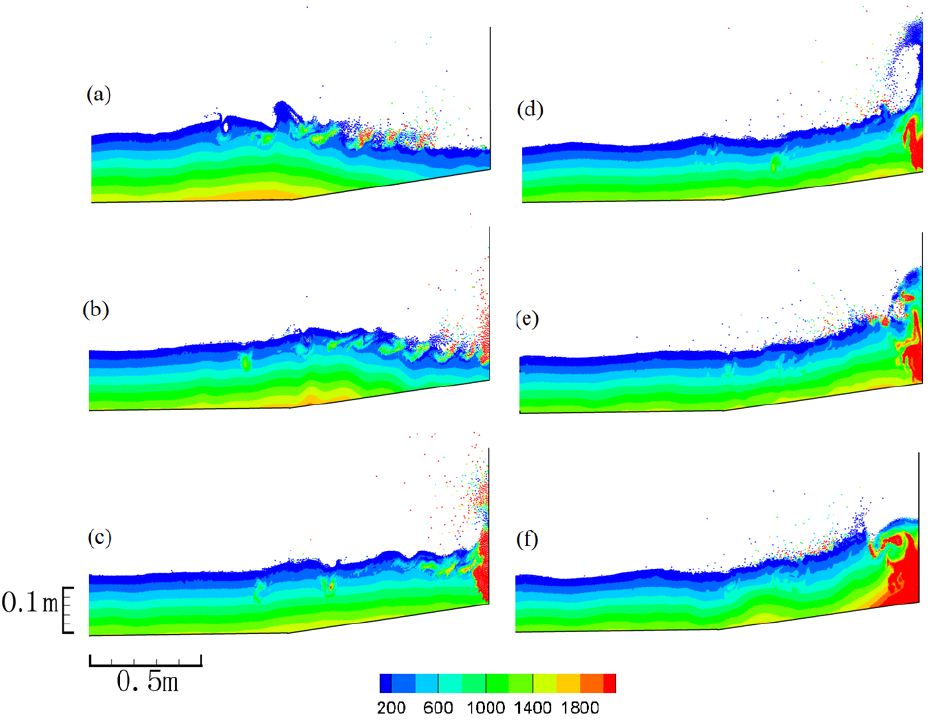
Fig. 10. Snapshots of SPH results (case C) of breaking wave impact on the wall and pressure distribution at time instances (a) 15.0s,